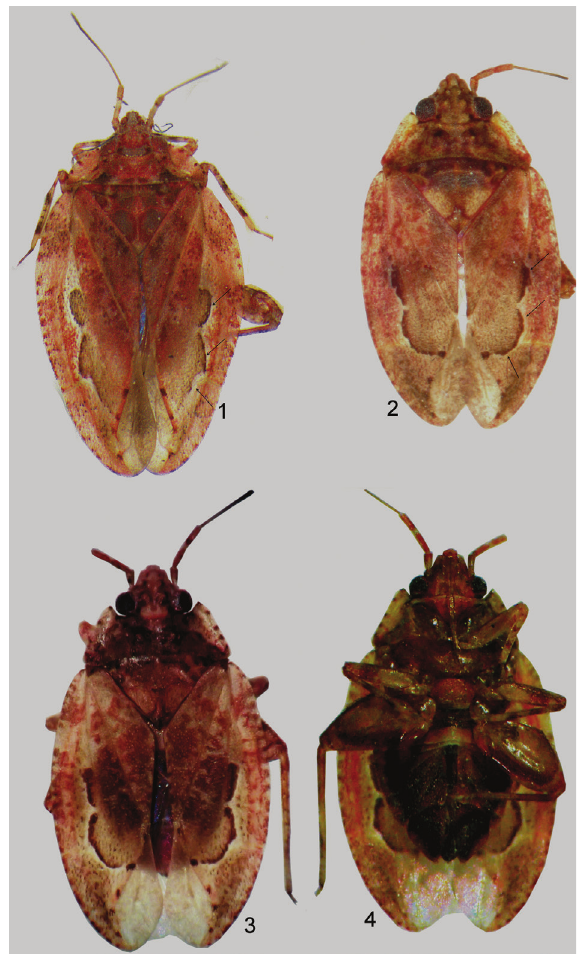
Figures 1–4. Dorsal habitus photograph of Sulawesifulvius schuhi ( 1 ♂ paratype) and S. thailandicus ( 2 holotype 3 ♀ paratype). Ventral view of S. thailandicus ( 4 ♀ paratype).